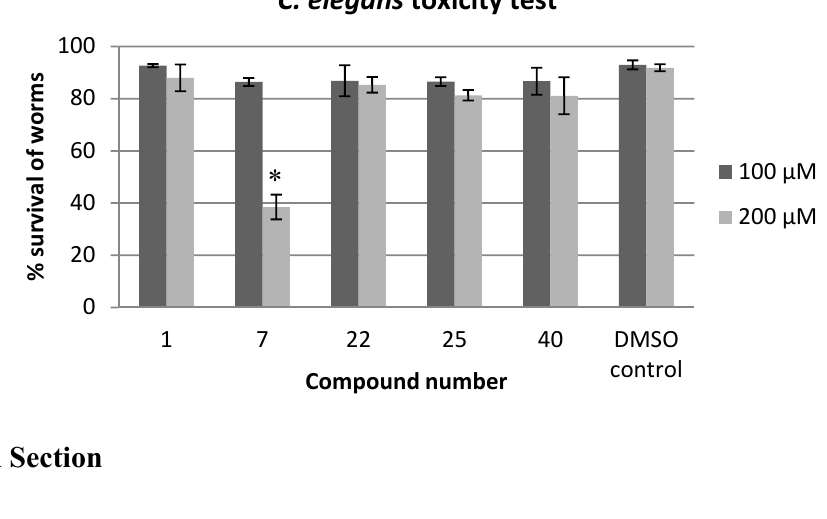
Figure 7. Effect of selected compounds (100 and 200 µM) on the survival of C. elegans , after 7 days of exposure. The % survival of the worms in the presence or absence (DMSO background) of anti-biofilm compounds was calculated after 7 days relative to their viability at day 0. Bars and error bars represent resp. means and standard errors of four